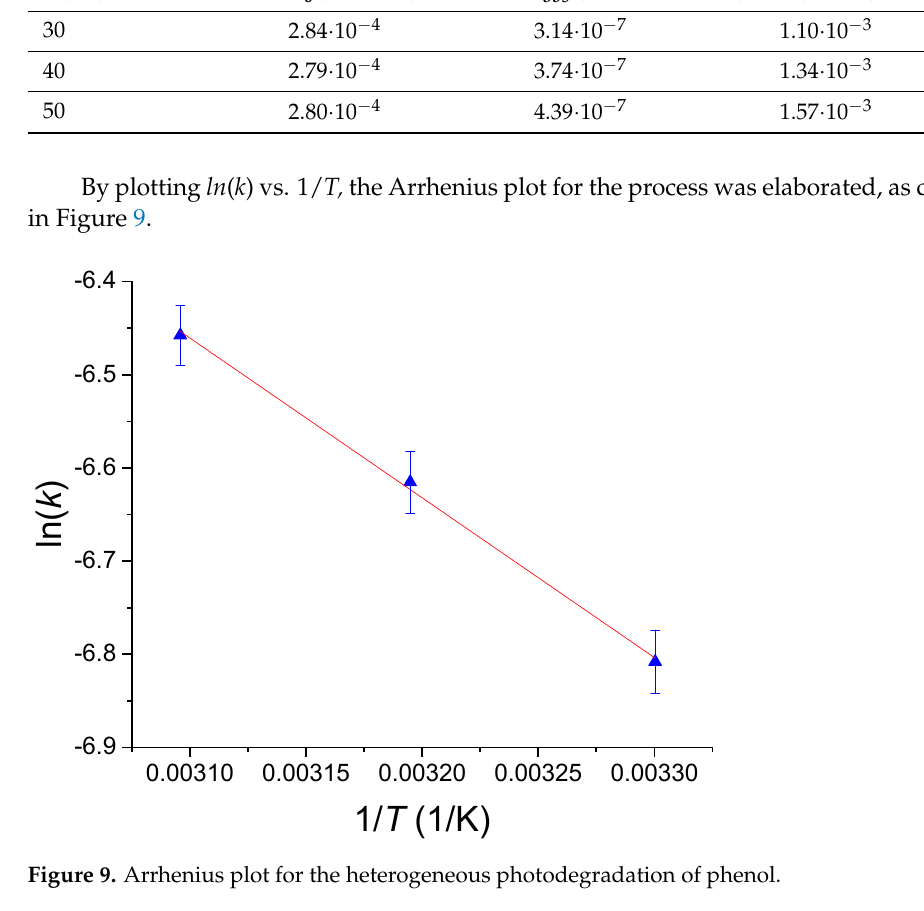
Figure 9. Arrhenius plot for the heterogeneous photodegradation of phenol. From the slope of the Arrhenius plot(cid:31)s linear regression line, the activation energy was calculated; the frequency factor was obtained from its intercept with the y-axis (Table 4). Table 4. Kinetic parameters obtained from the Arrhenius plot. ln ( k 0 )